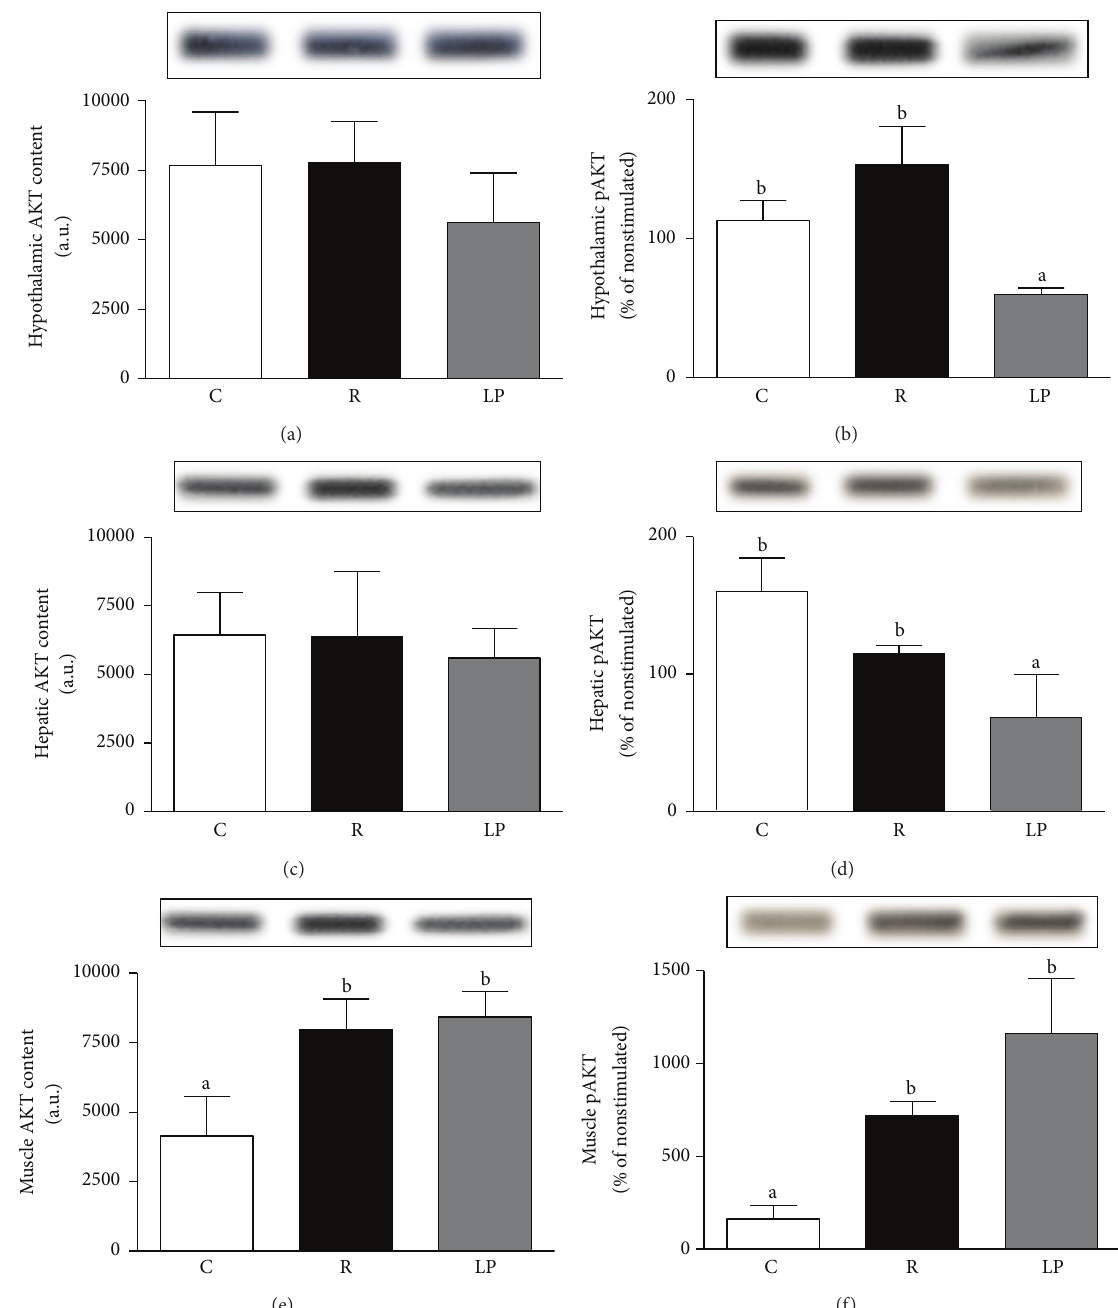
Figure 2: AKT content and AKT phosphorylation in hypothalamus ((a) and (b)), liver ((c) and (d)), and skeletal muscle ((e) and (f)) of control (C), recovered (R), and low protein (LP) rats. AKT phosphorylation data represent the percentage of nonstimulated values. The rats were injected with saline (not shown) or insulin, and 45s, 90 s, and 15 minutes later, liver, hind-limb skeletal muscle, and hypothalamus, respectively, were excised and homogenized as described in the Materials and Methods section. Data are presented as means ± SEM. Mean values with unlike superscript letters were significantly different ( 𝑃 < 0.05 , LSD